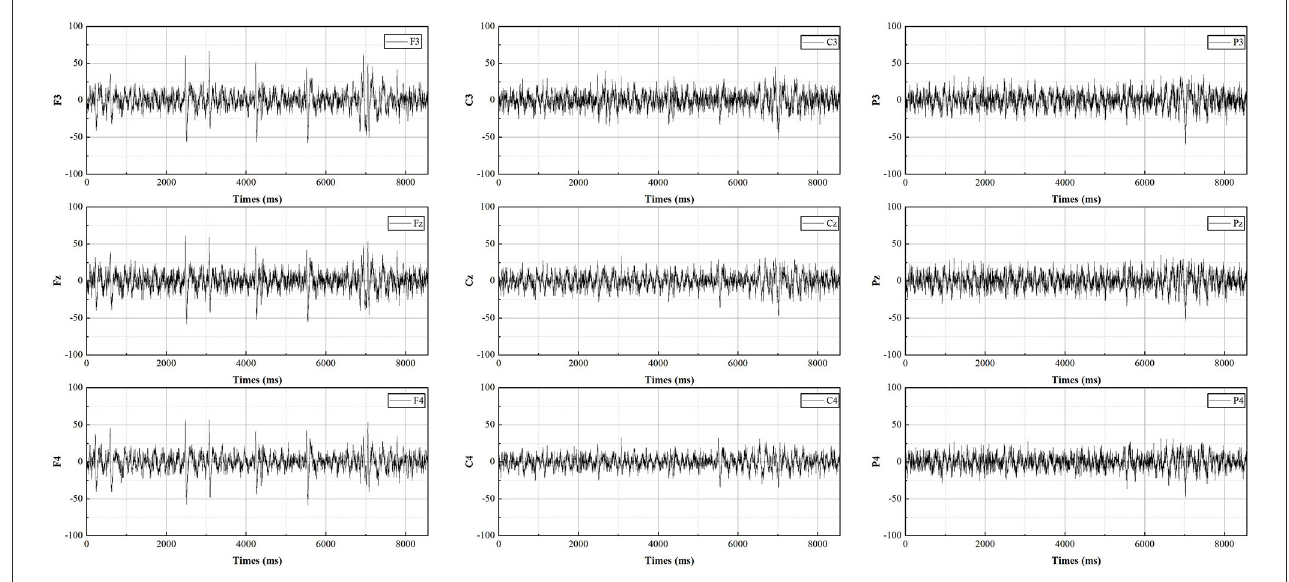
FIGURE4 The average potential value for males during vertical swiping.